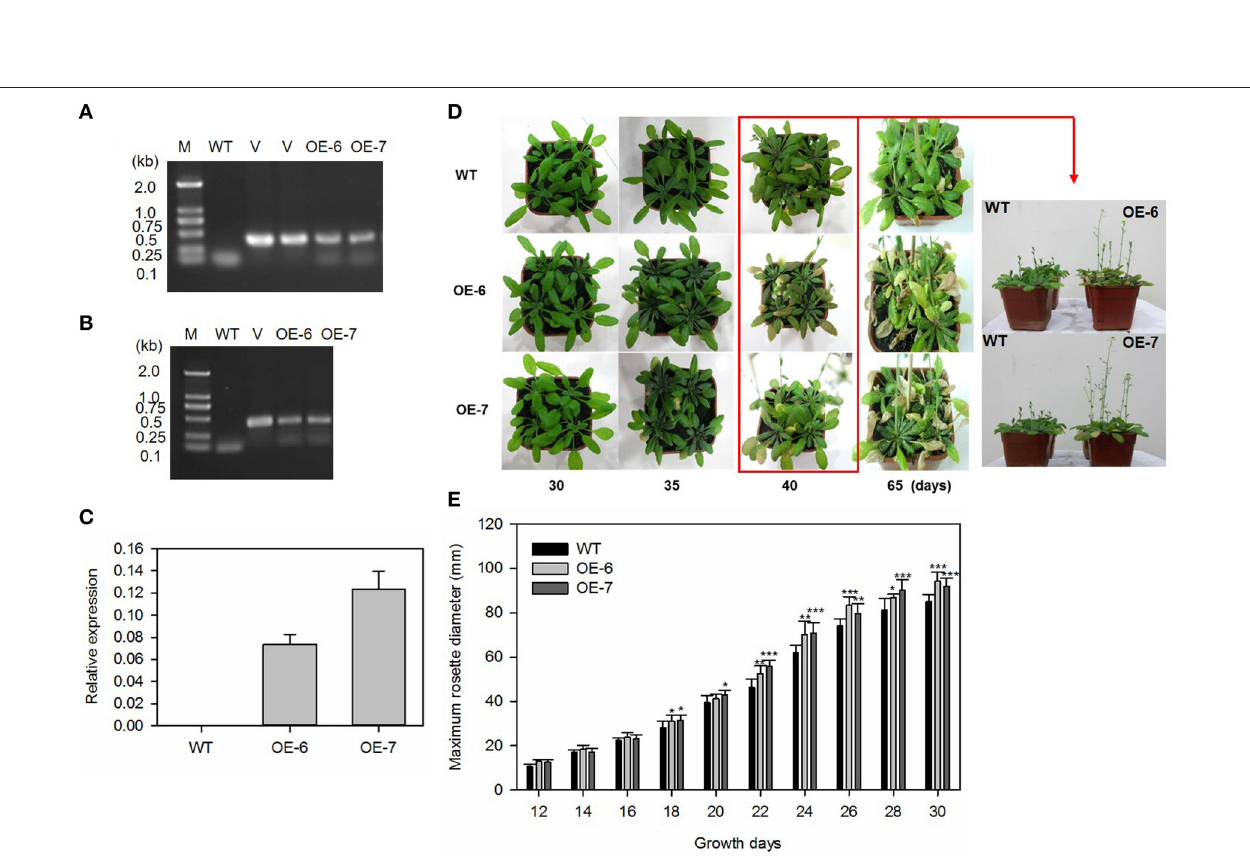
Frontiers in Plant Science |